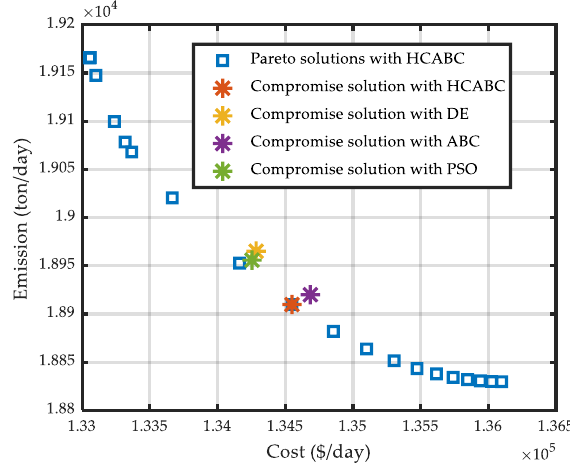
Figure 7. Pareto front for case 1.